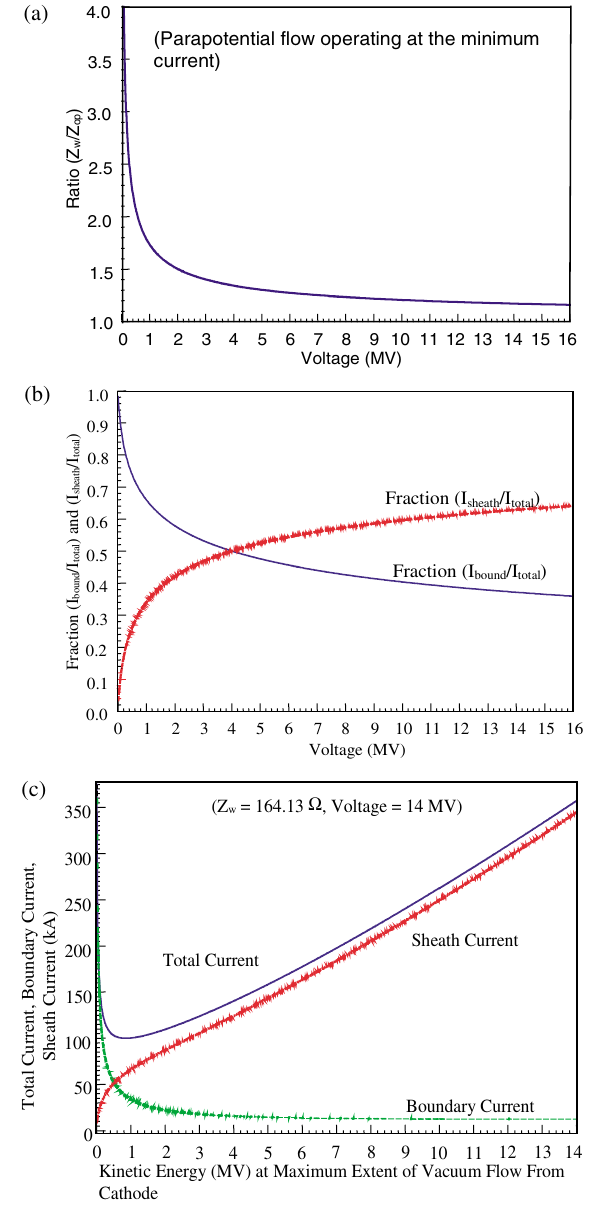
FIG. 14. (Color) Magnetic insulation parameters as a function of voltage: (a) ratio of vacuum impedance to operating imped- ance of a MITL; (b) fractions of bound and sheath current in a MITL; (c) range of operating currents in a MITL [31].